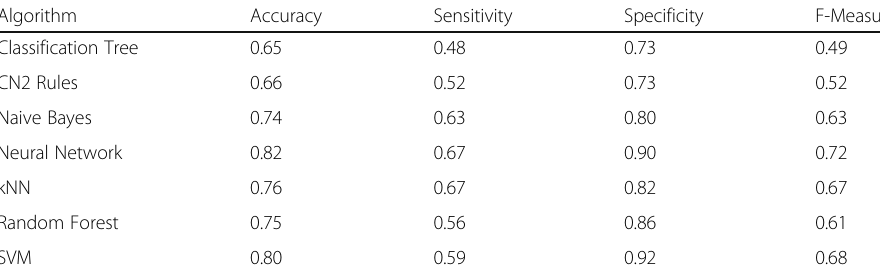
Table 4 Data Transformation: None, Feature Selection: None